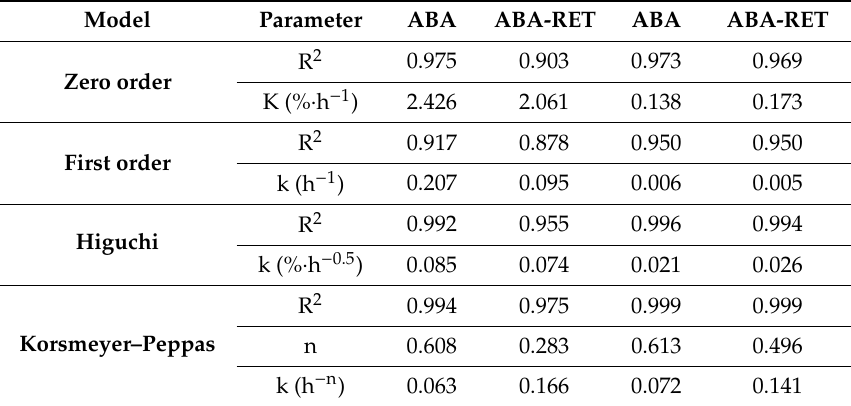
Table 6. Kinetics analysis for the release